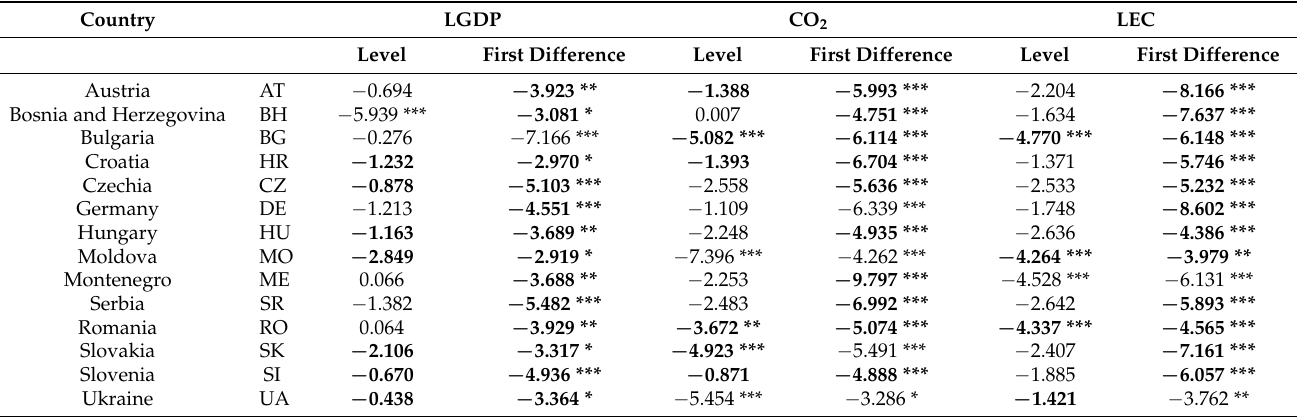
Table 2. Augmented Dickey–Fuller unit-root